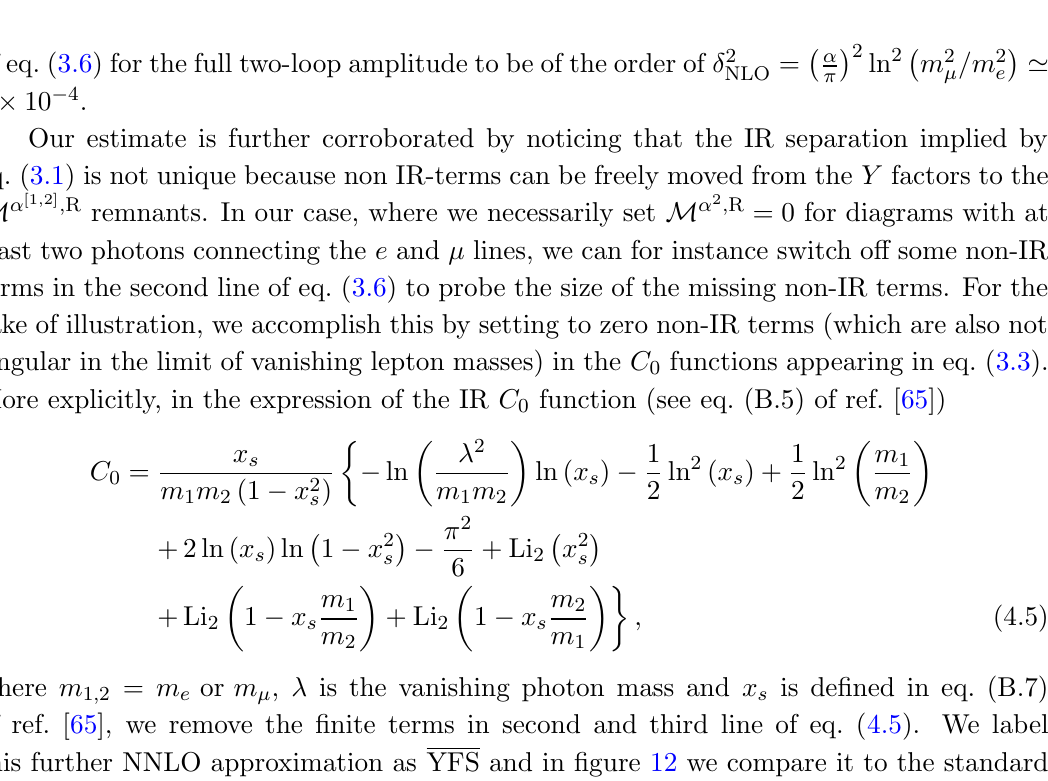
Figure 11 . Di(cid:11)erence between NLO box diagrams approximated (cid:18)a la YFS and the exact calcu- lation, as a function of the t ee (left) and # e (right)